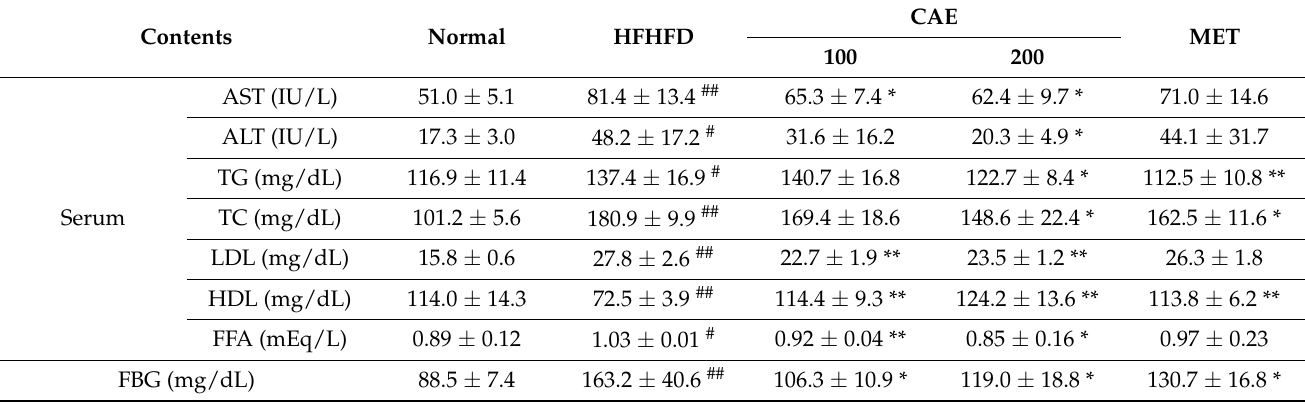
Table 1. Blood and serum biochemistry